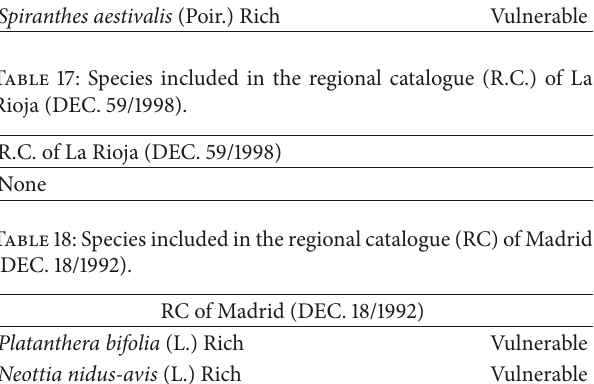
Table 16: Species included in the regional catalogue (RC) of Galicia (DEC. 88/2007). RC of Galicia (DEC. 88/2007)